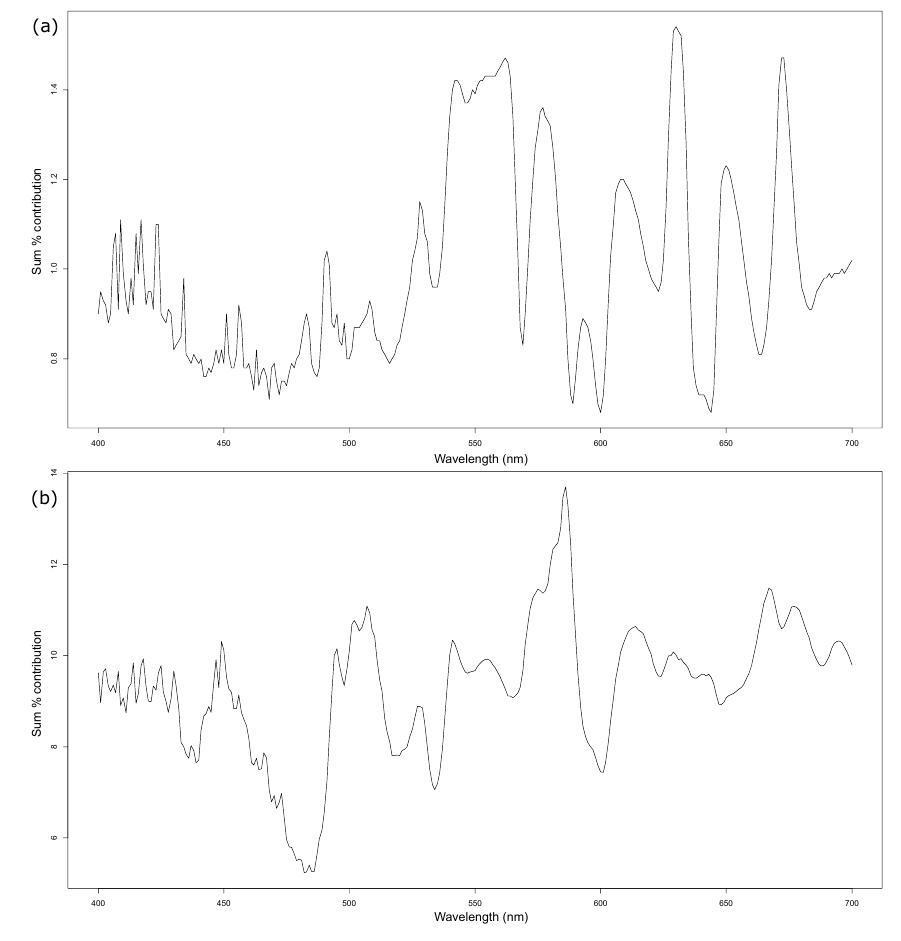
Figure 6. 1-way SIMPER analysis sum percentage contribution to significant dissimilarities made by wavelengths: ( a ) Between groups. ( b ) Between